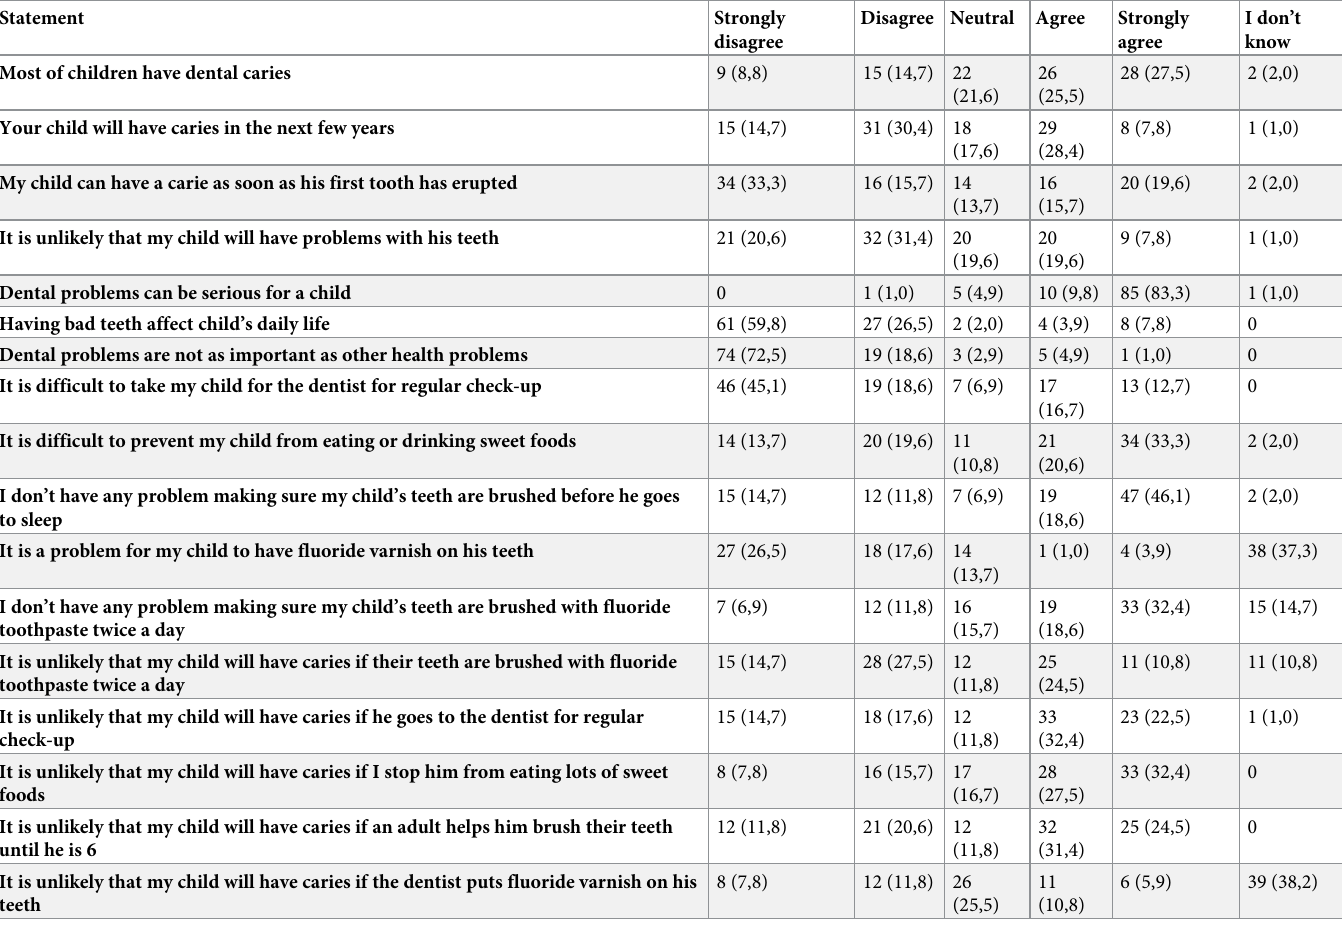
Table 5. Parental oral health belief